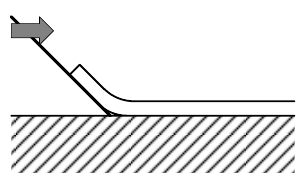
Fig. 6 Schematic view of the peel test in the present